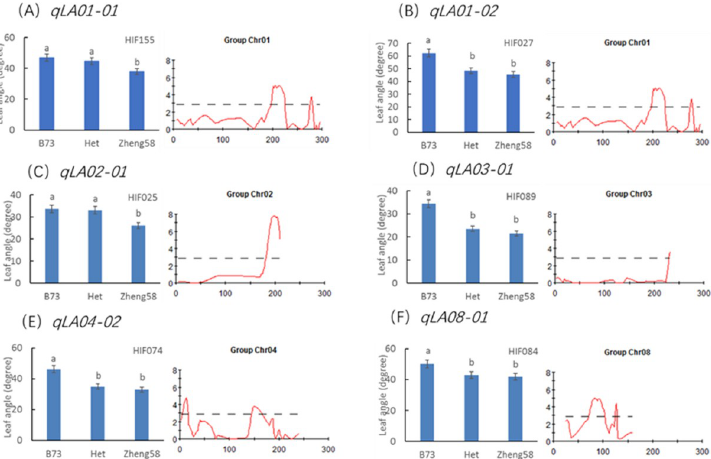
Fig 4. Significant analysis of the mean values of different genotypes in the same HIF population. The same letter indicates no significant difference between them, and different letters indicate a significant difference (P value < 0.05).